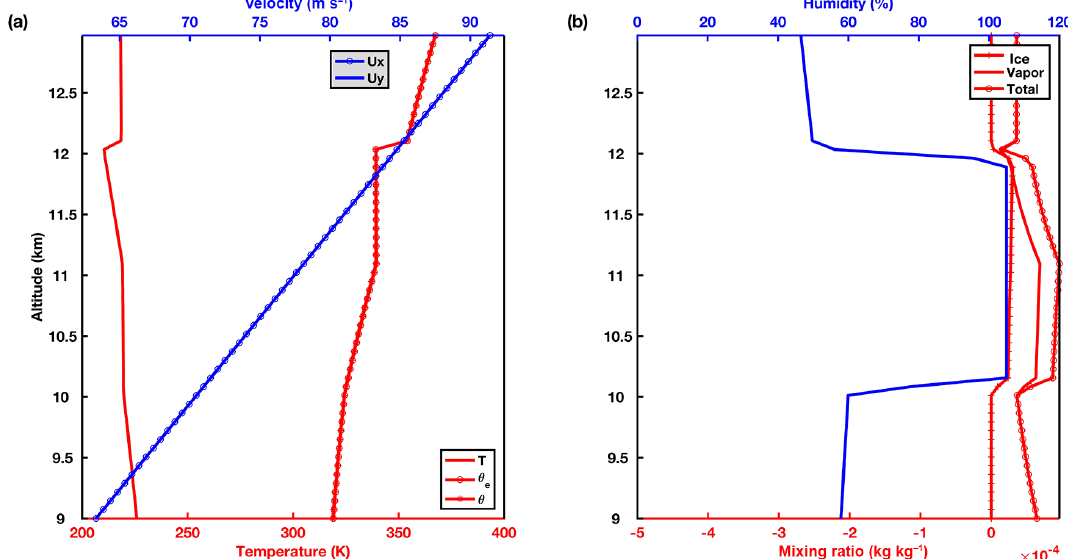
Figure 2. Meteorological profiles used to generate a realistic 3-D cirrus cloud field. (a) Wind velocity U x and U y (in blue) on the x and y axes, respectively; temperature T ; potential temperature θ and equivalent potential temperature θ e (in red) as functions of the altitude. Panel (b) shows relative humidity (in blue), ice, vapor and total mixing ratios (in red) as functions of the altitude. Note that U x and U y are over-imposed because of wind blow at 45 ◦ with respect to the x and y axes and θ and θ e are also